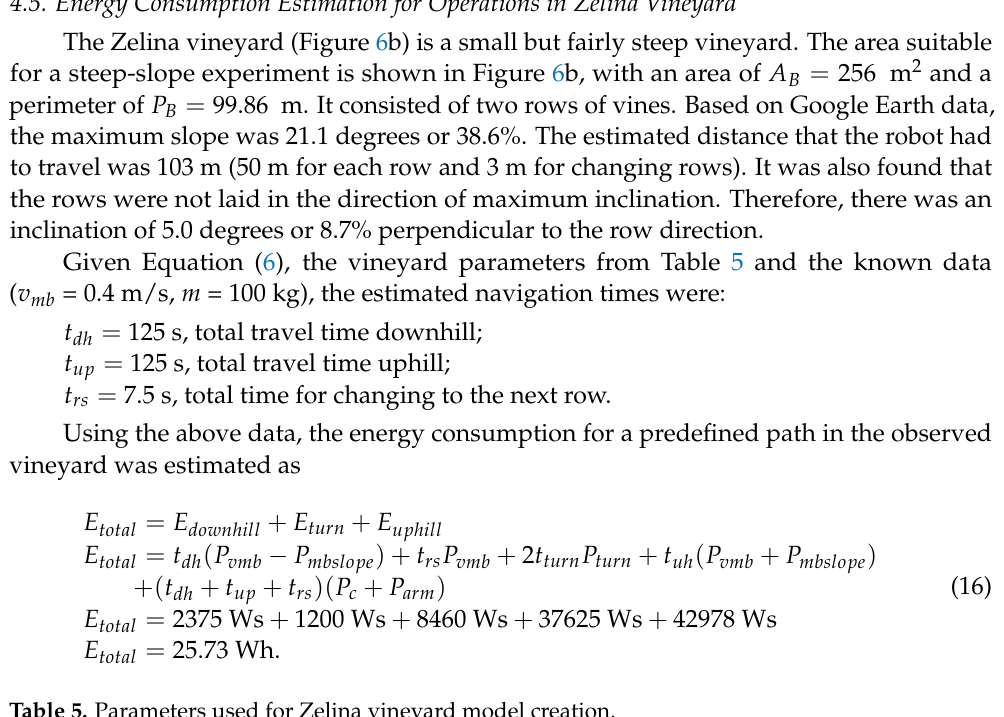
Table 5. Parameters used for Zelina vineyard model